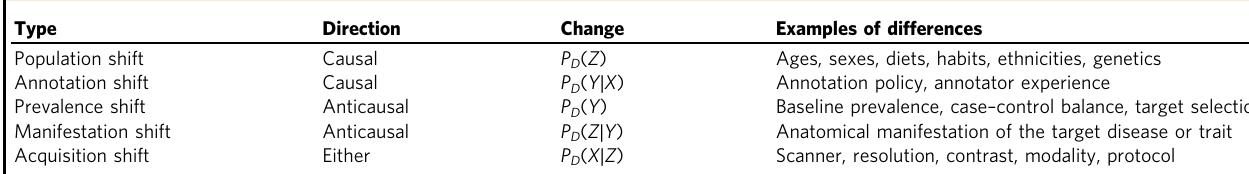
Table 1 Types of dataset